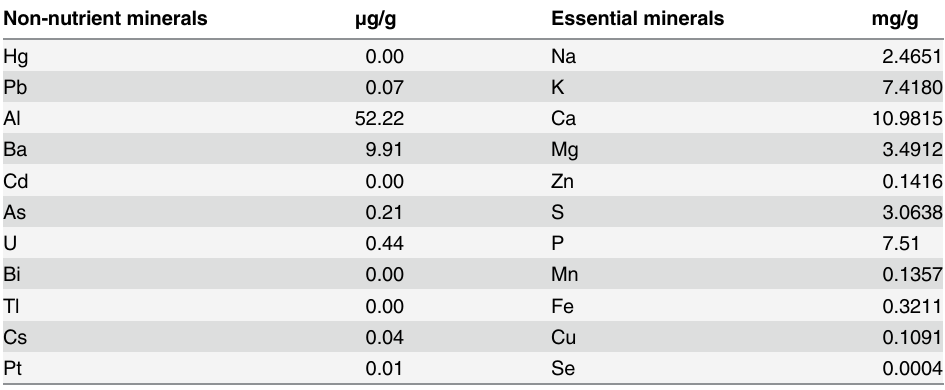
Table 1. Essential nutrient and non-nutrient mineral components of the mouse